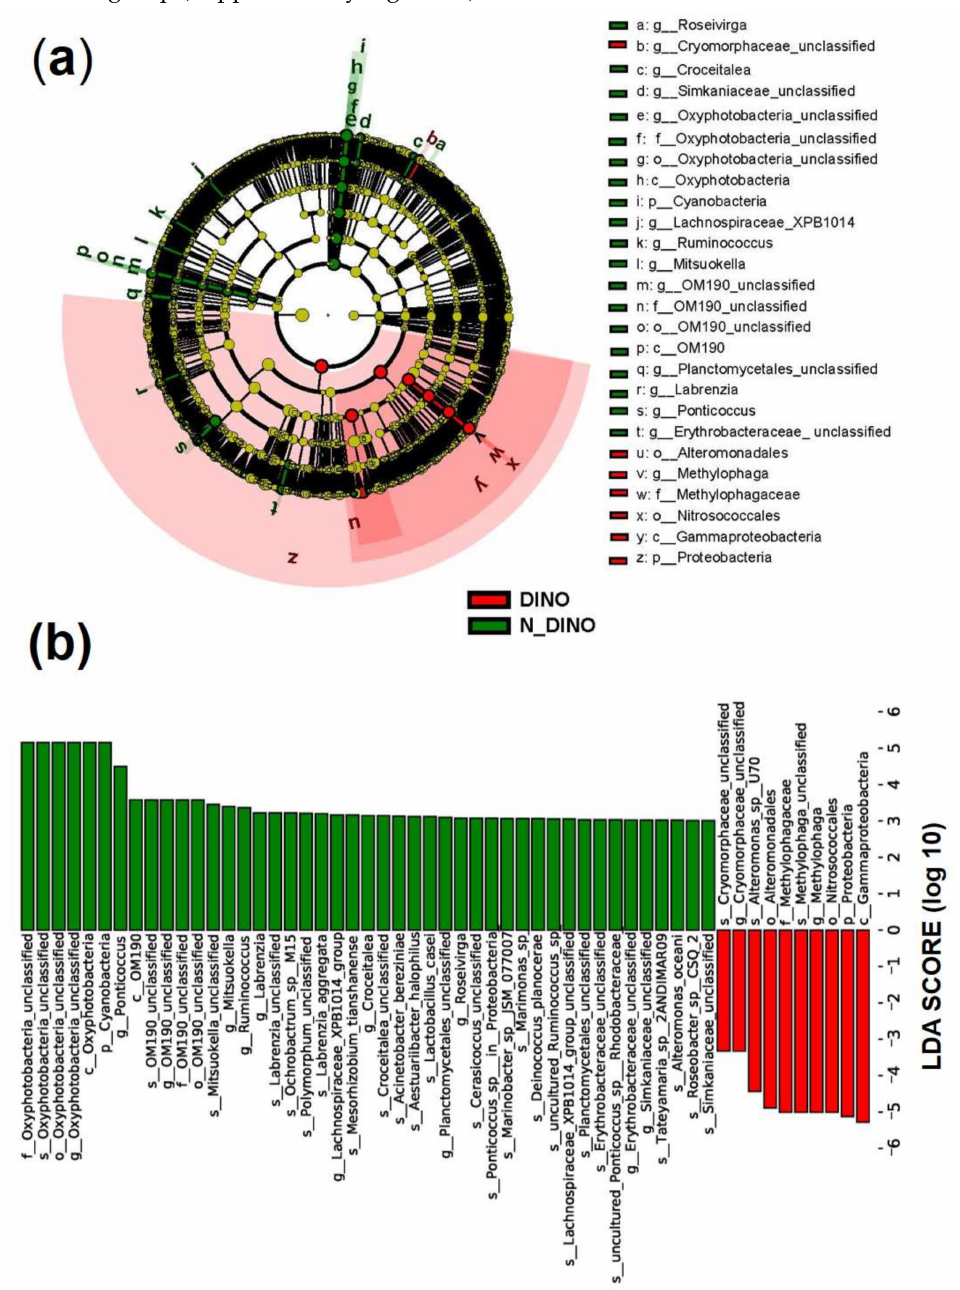
Figure 5. Linear discriminant analysis (LDA) integrated with effect size (LEfSe). ( a ) Cladogram illustrating the phylogenetic distribution of bacterial taxa differentially represented between DINO (red) and N-DINO (green) groups. ( b ) The differences in abundance of represented taxa between DINO (red) and N-DINO (green)